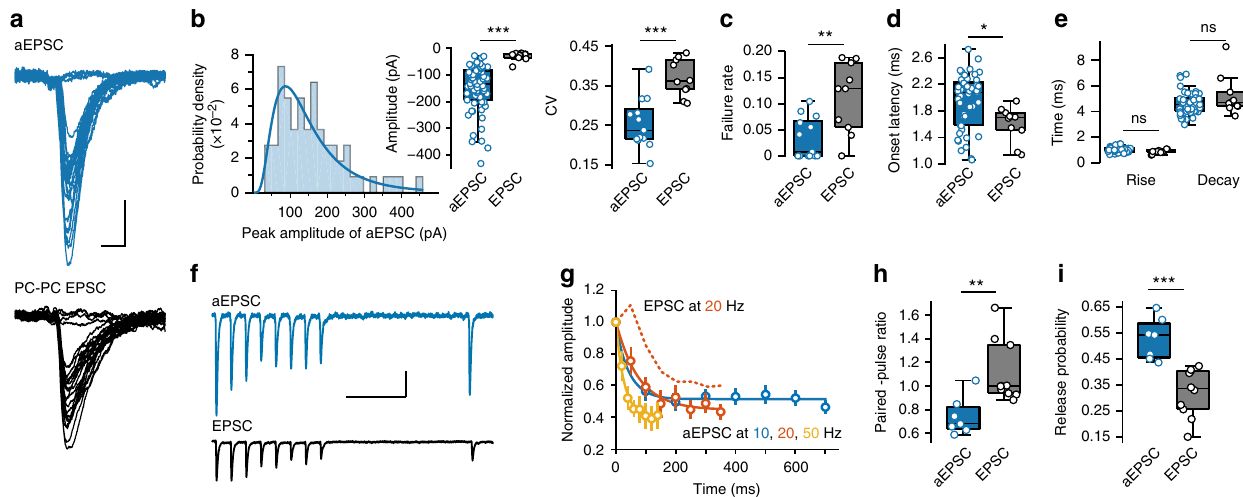
Fig. 3 Properties of unitary aEPSCs and PC – PC EPSCs. a Two representative recordings showing aEPSCs (top, simultaneous soma and axon recording with laser axotomy, overlap of 26 trials) and PC – PC EPSCs (bottom, paired PC – PC recording, 25 trials). Scale bars: 5 ms/100 pA for aEPSC and 20 pA for EPSC. b Distribution of aEPSC peak amplitudes with a lognormal fi t (left). Middle and right, comparisons of the average peak amplitude (Wilcoxon rank-sum test) and CV (two sample Student ’ s t -test) of aEPSC and EPSC. Boxplots represent the median and interquartile range and whiskers represent 1.5× interquartile range. c , d , e Group data showing the average failure rates (Wilcoxon rank-sum test), the onset latency (two sample Student ’ s t -test), the rise time and decay time constant (Wilcoxon rank-sum test) of aEPSC and EPSC. f Top, an average trace showing short-term plasticity of aEPSCs in response to 20-Hz stimulation at the axon. Bottom, an average trace of EPSCs obtained from a PC – PC pair recording. Scale bars: 200 ms/50 pA. g Plot of the normalized peak amplitudes of aEPSCs at different frequencies and their single exponential fi ts. PC – PC EPSCs (20 Hz) are shown for comparison (dashed line). Data are represented as mean ± SEM. h , i Comparisons of paired-pulse ratio (interval: 50 ms; Wilcoxon rank-sum test) and release probability (two sample Student ’ s t -test) of aEPSC and EPSC. * P < 0.05; ** P < 0.01; *** P < 0.001; ns not signi fi